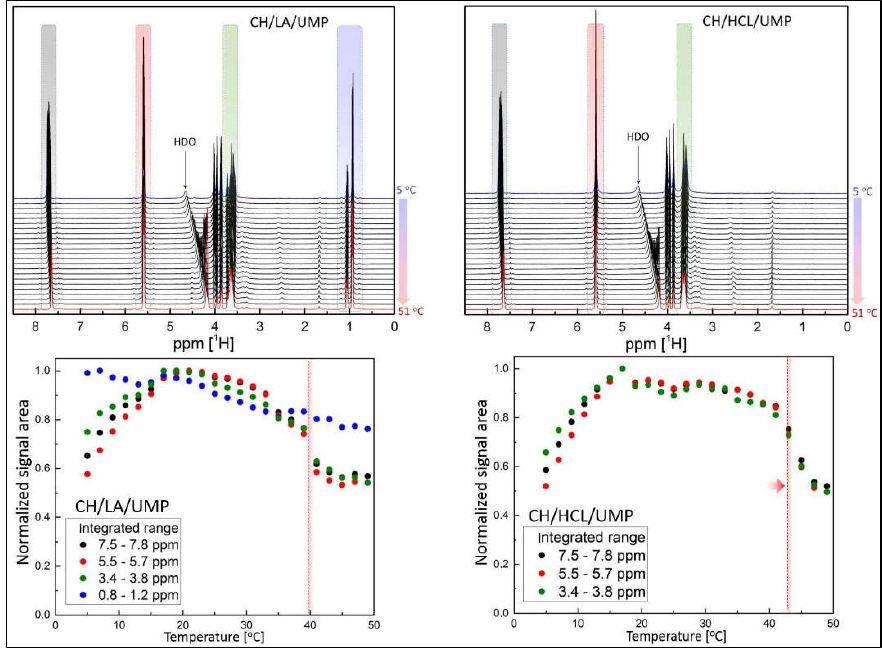
Figure 8. (top) The 1 H NMR spectra recorded for the CH/LA/UMP and CH/HCL/UMP systems in Figure 8. ( top ) The 1 H NMR spectra recorded for the CH/LA/UMP and CH/HCL/UMP systems in the temperature range of 5–51 °C; (bottom) The NMR signal intensity vs. temperature. the temperature range of 5–51 ◦ C; ( bottom ) The NMR signal intensity vs.